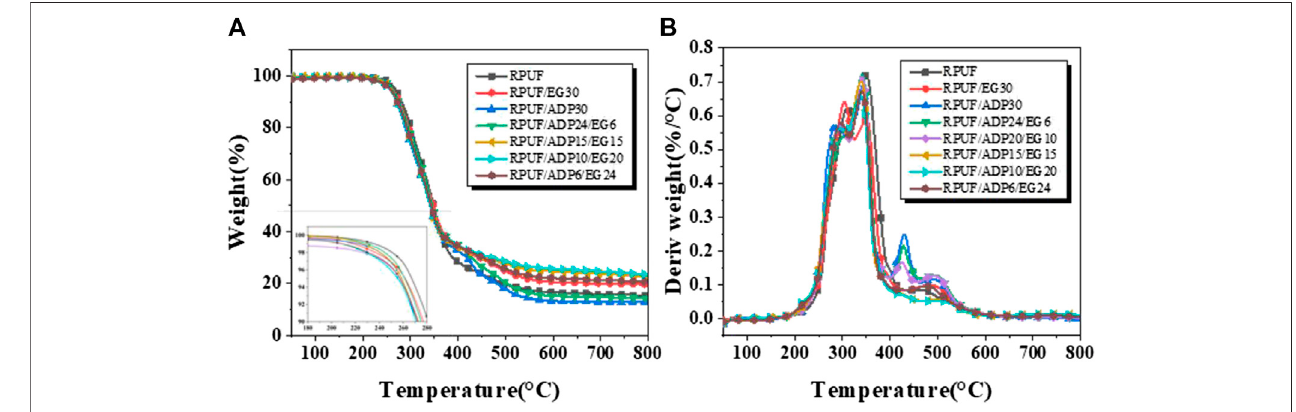
FIGURE 2 | (A) TGA and (B) DTG curves of RPUF and FR-RPUF composites under N 2 .